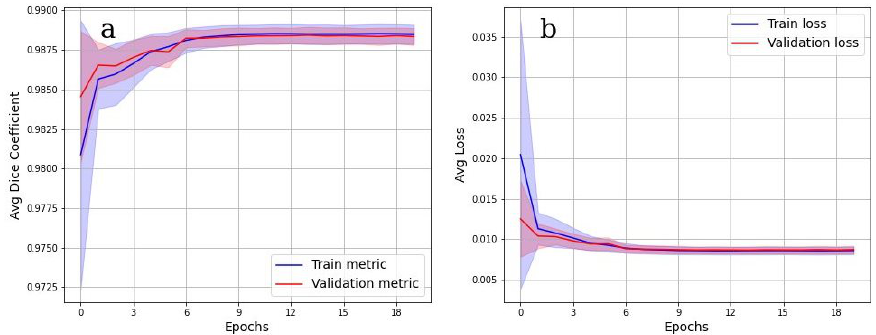
Figure 7. Binarization results. ( a ) Dice coefficient on training and validation datasets. Binarization quality increases as the coefficient approach 1; ( b ) loss curve on a training and validation dataset over 5